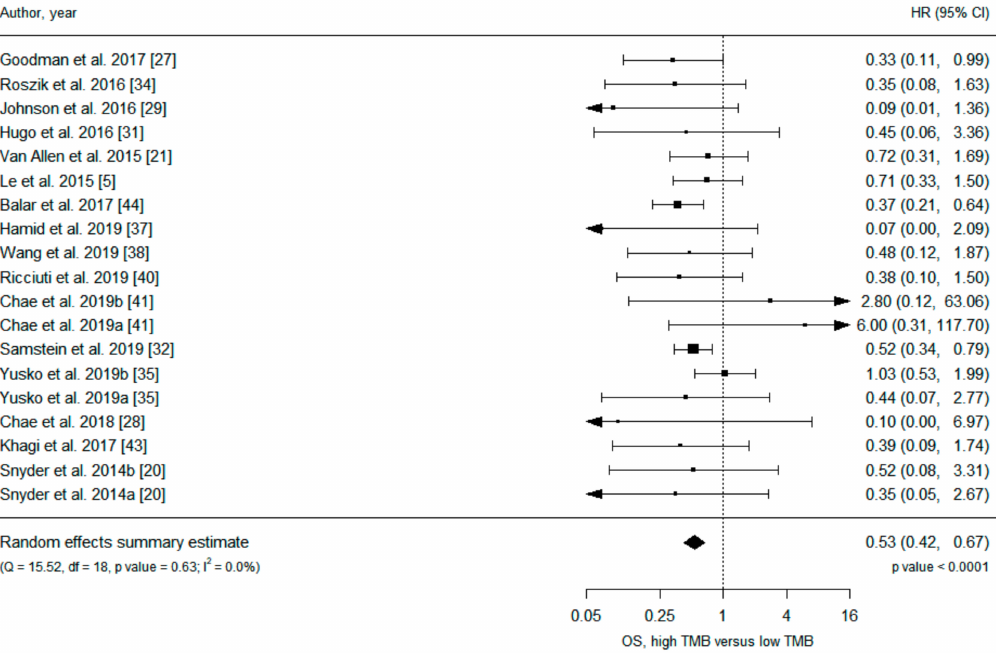
Figure 2. Meta-analysis of immune checkpoint inhibitor therapy and overall survival, high TMB group versus low TMB group.